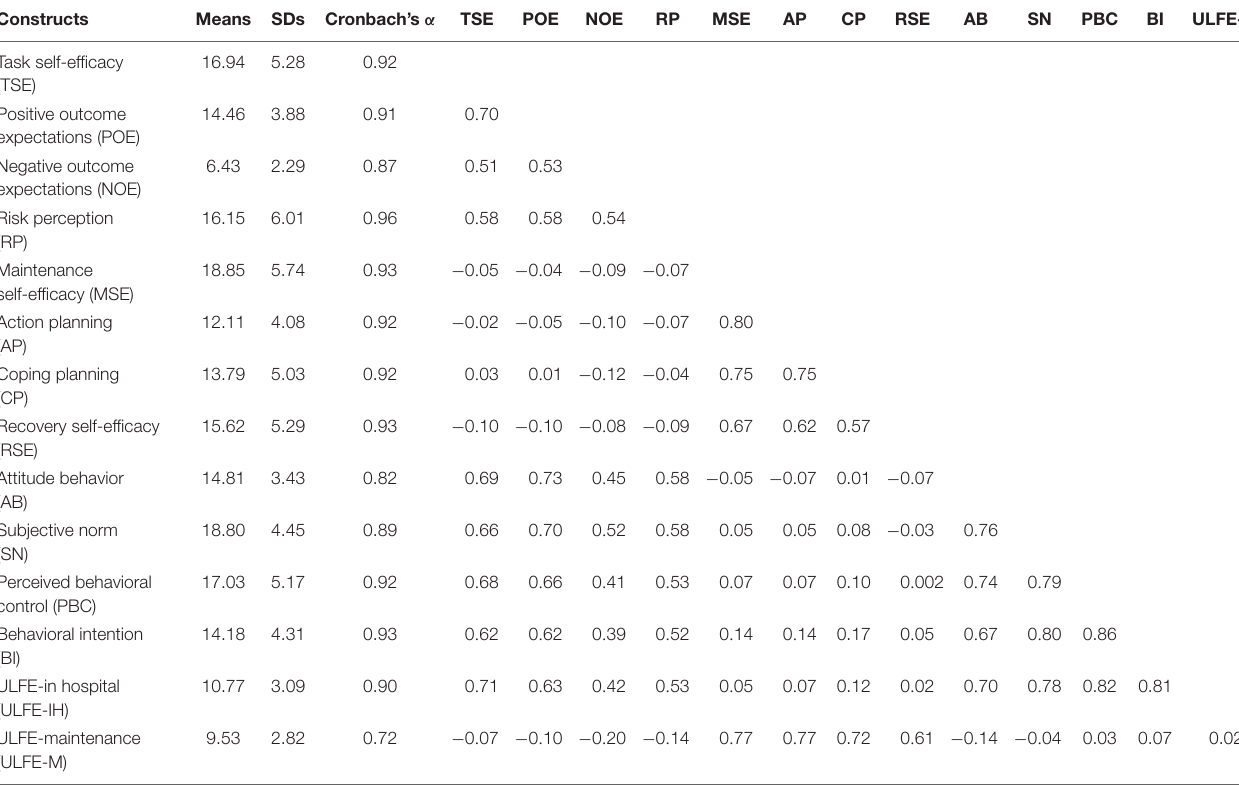
TABLE 2 | Upper limb functional exercise: Means, standard deviations (SDs), Cronbach’s α , and bivariate correlations for variables of the HAPA-TPB integrated model.